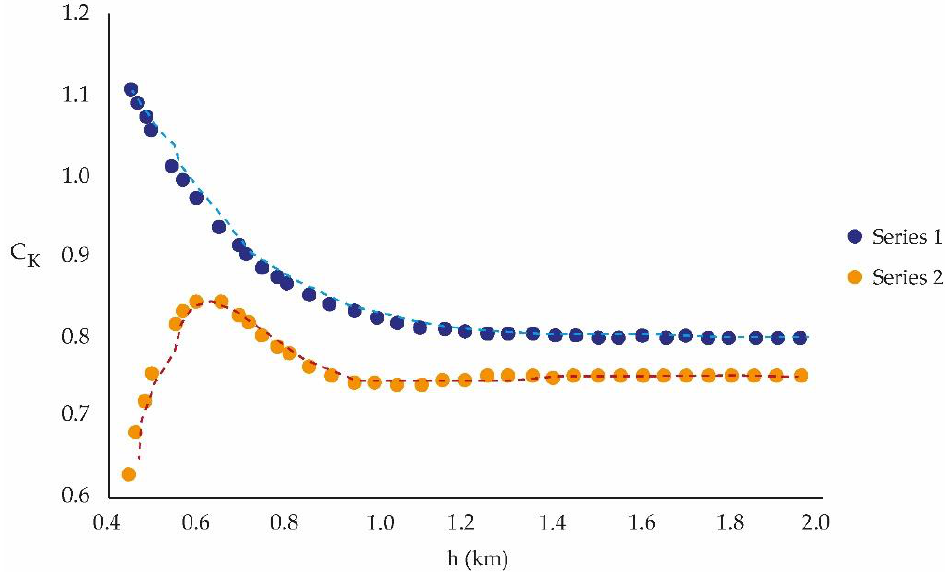
Figure 7. The approximate modeling of the C K entropy ratio according to the study periods, 2010–2013 (Series 1) and 2017–2020 (Series 2) with the domain of heights outside the range of measure- ments.